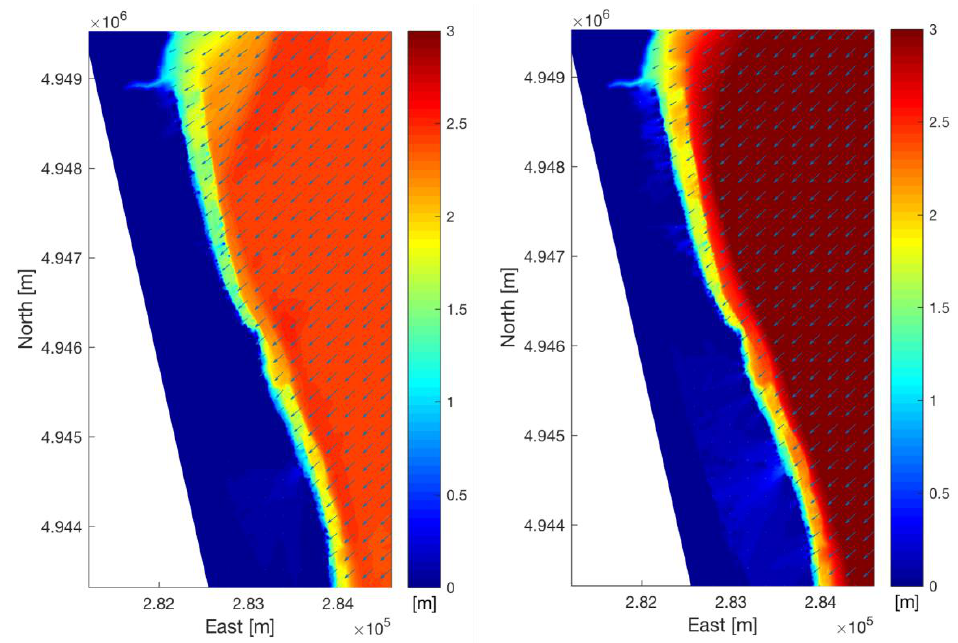
Figure 8. Bora events. Distribution of significant wave height and mean wave direction vectors for SCE—B1 ( left panel ) and SCE—B25 ( right panel ) runs, respectively. Since differences between runs may appear less significant than in reality on a scale of representation of the global model domain; a comparison of the results is performed along linear transects from the offshore computational boundary to the shoreline (as represented in the left panel